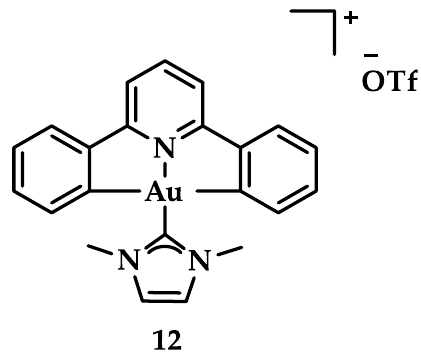
Figure 19. Chemical structure of complex [Au(CˆNˆN)(Ime)]PF 6 , with Ime = 1,3-dimethylimidazol-2-ylidene.